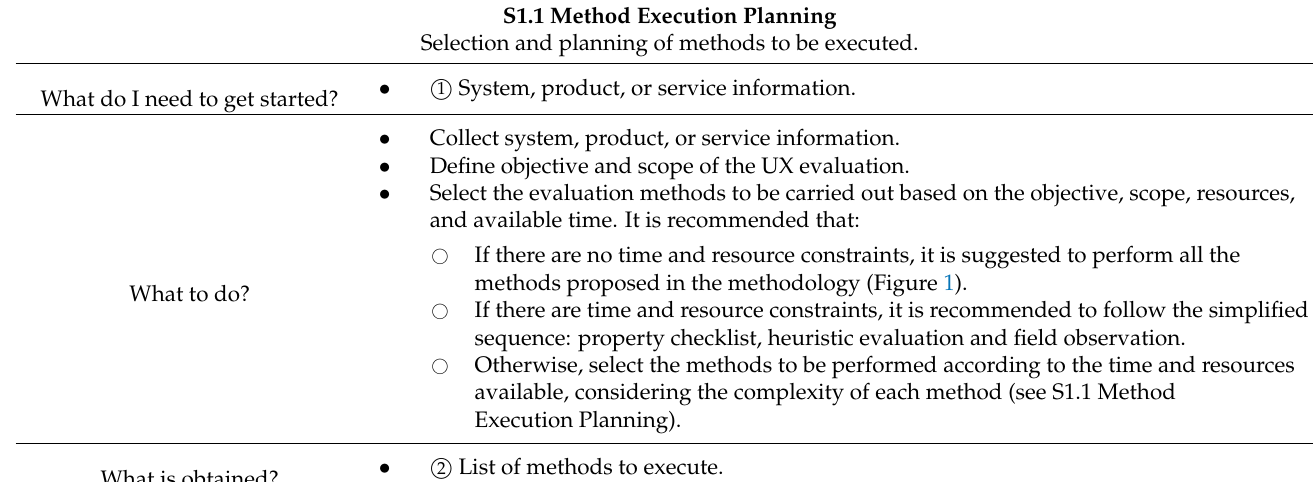
Table A2. Method Execution Planning Specification.